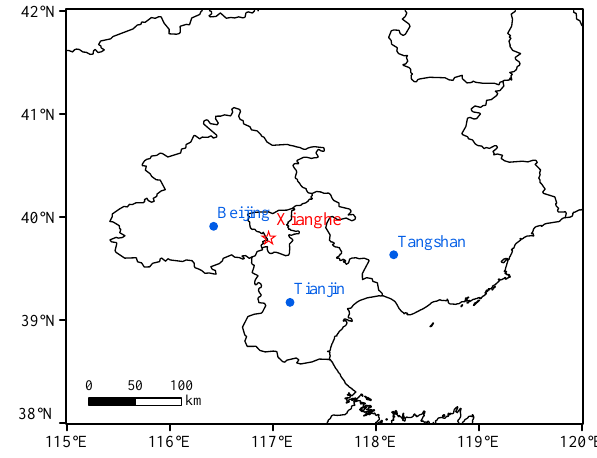
Figure 1. Location of the Xianghe Observatory (red star) and major neighborhood